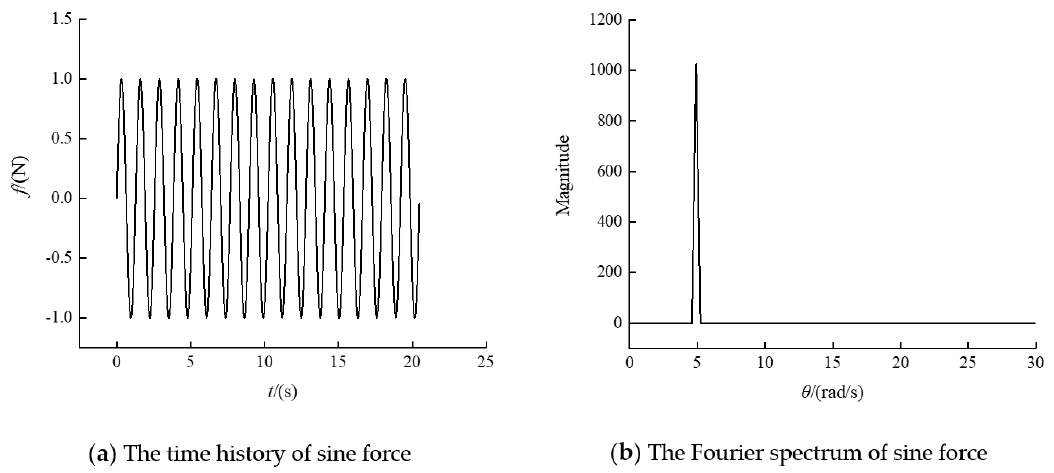
Figure 2. The time history and Fourier spectrum of zero mean harmonic force.